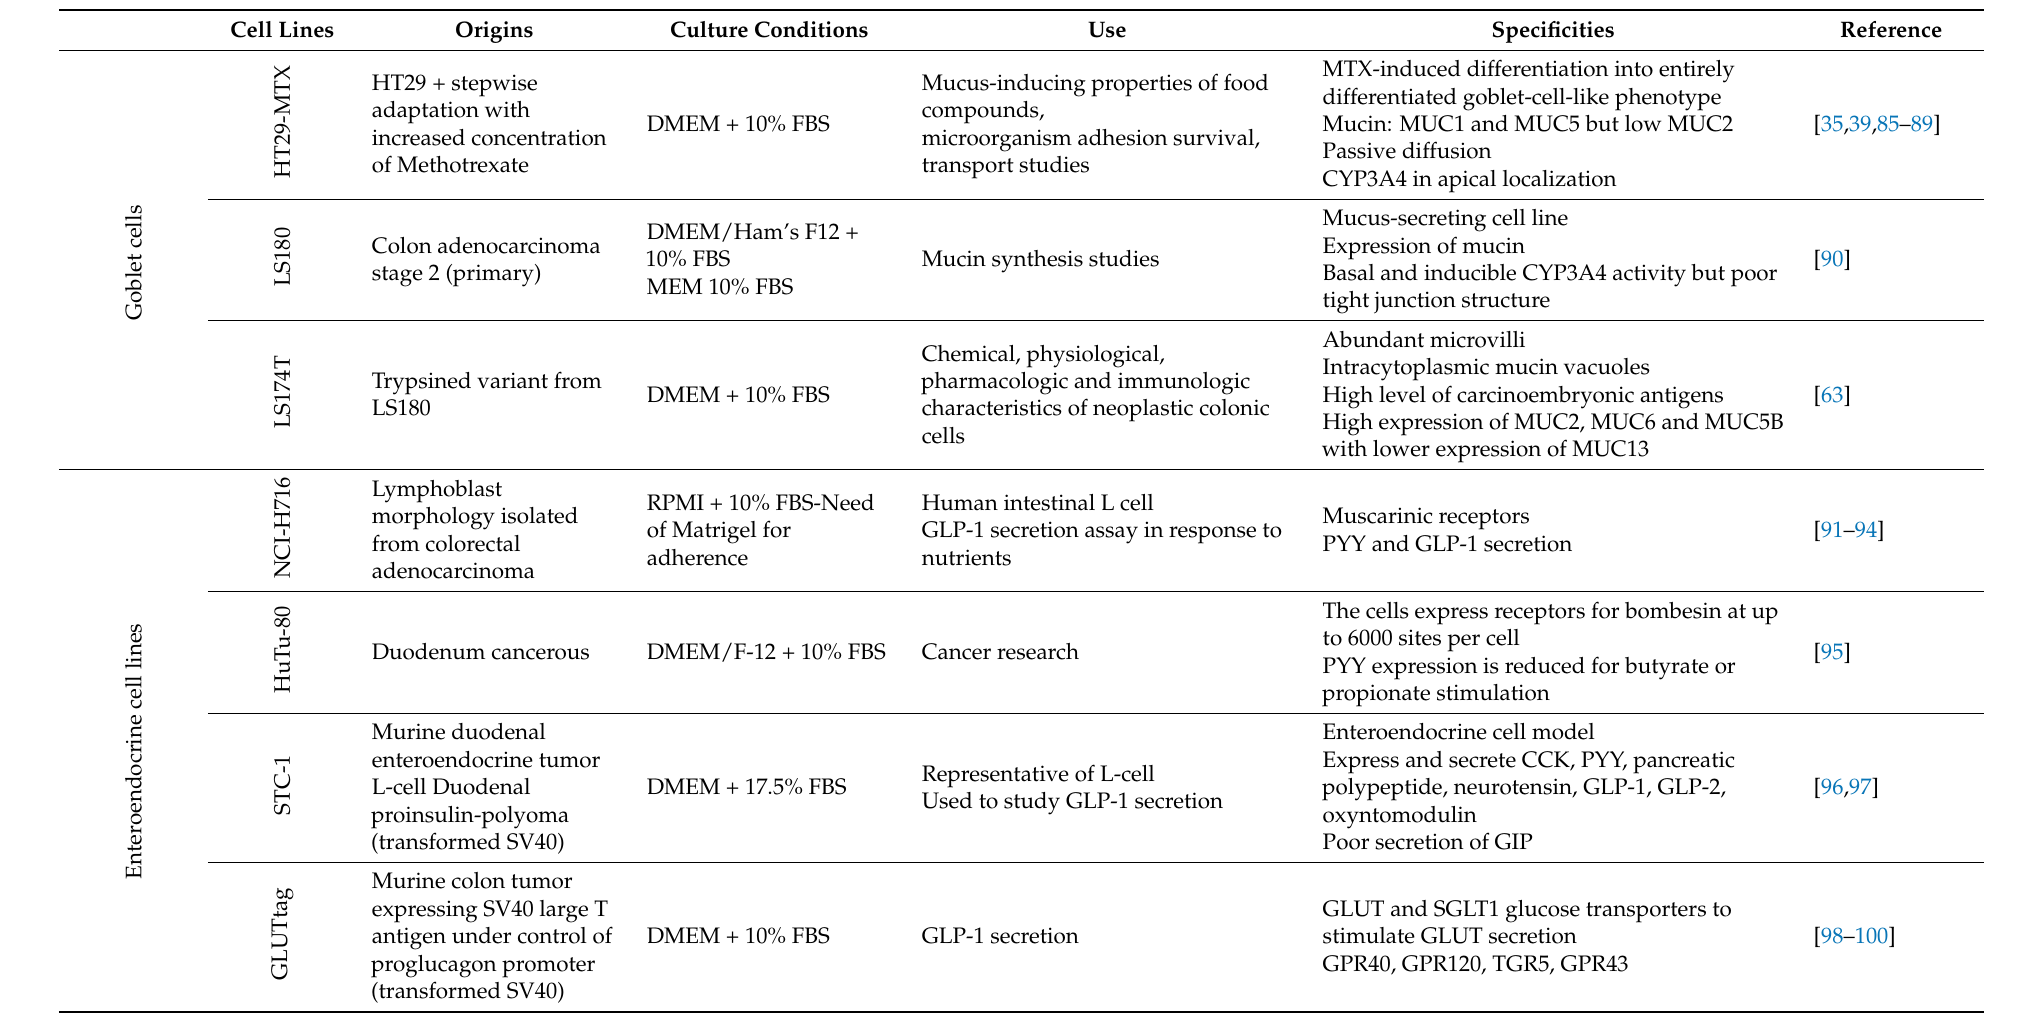
Table 2. Main secreting cell